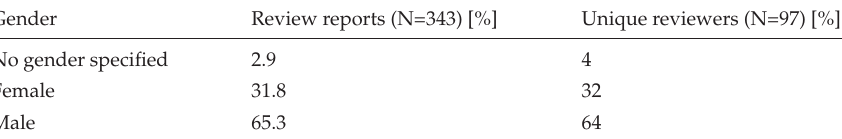
Table 2: Review reports and reviewers according to gender